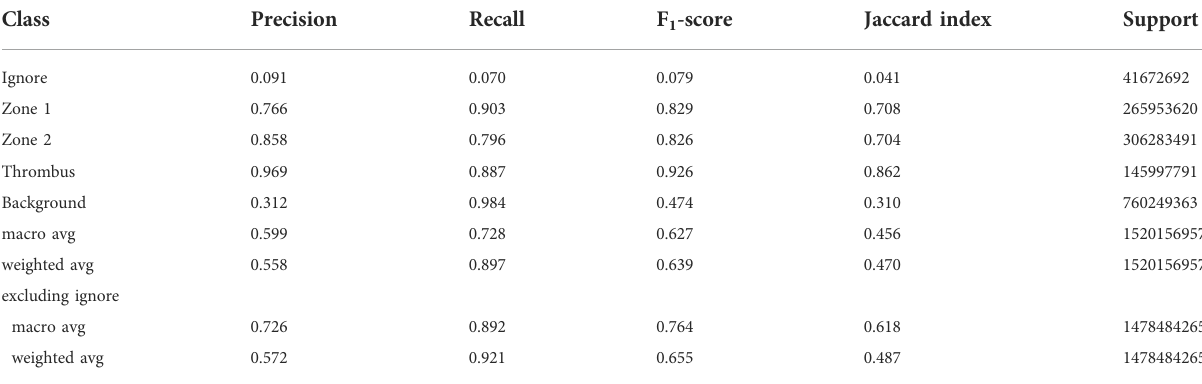
TABLE 2 Classi fi cation reportfor the performance ofthe network model on the validation dataset. The macroaveragesare the unweighted means of each metric, while the weighted averages are the support-weighted means. The bottom two rows were calculated with the assumption that all data labeled Ignore are irrelevant to the performance and thus excluded.